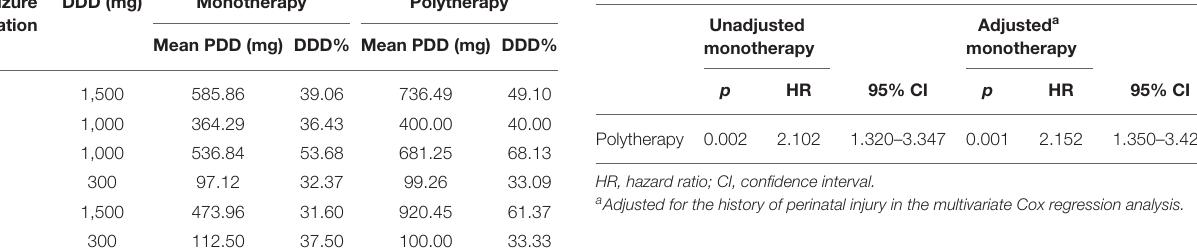
TABLE 4 | Comparison of seizure relapse risk between patients treated with monotherapy and polytherapy. Unadjusted monotherapy